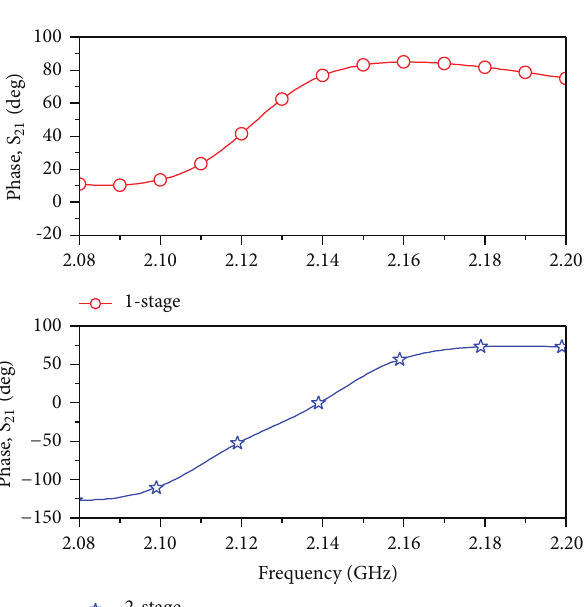
Figure 6: Measured phase characteristics of balanced type NGD